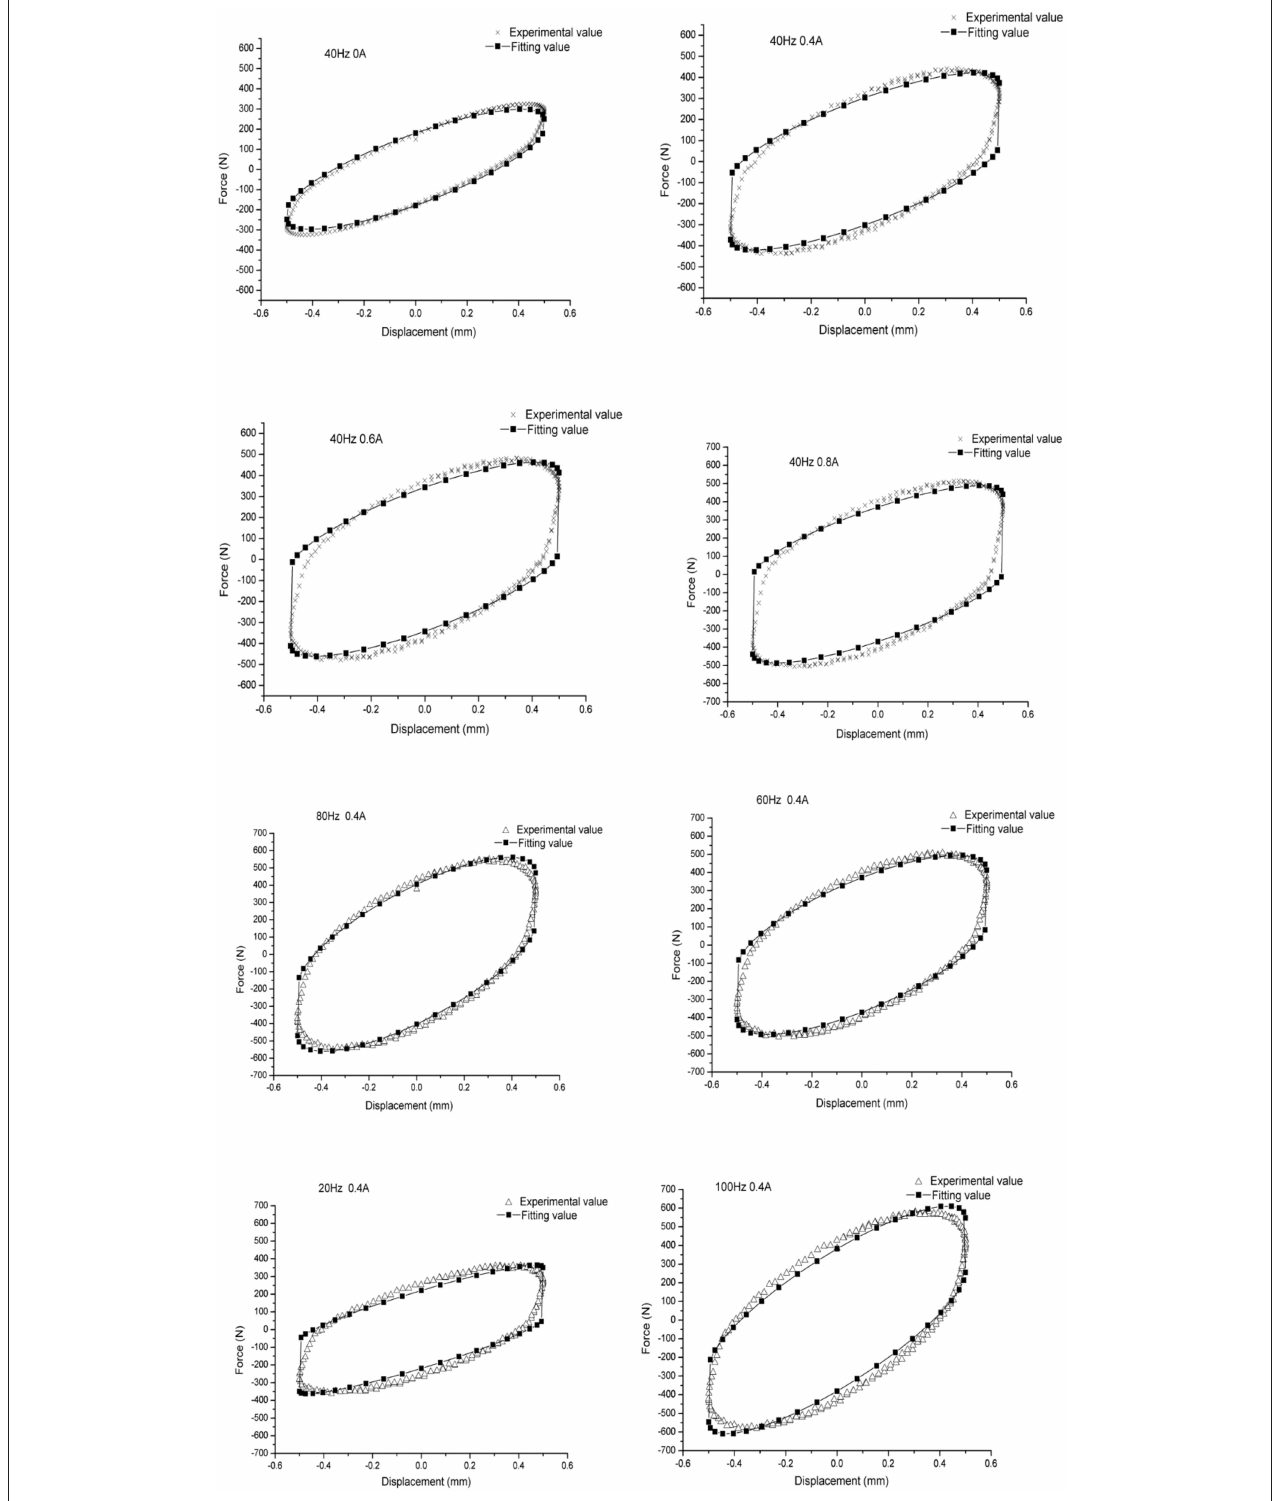
FIGURE 14 | Contrast fitting value figure of the experimental value of hysteretic curve under all working conditions.